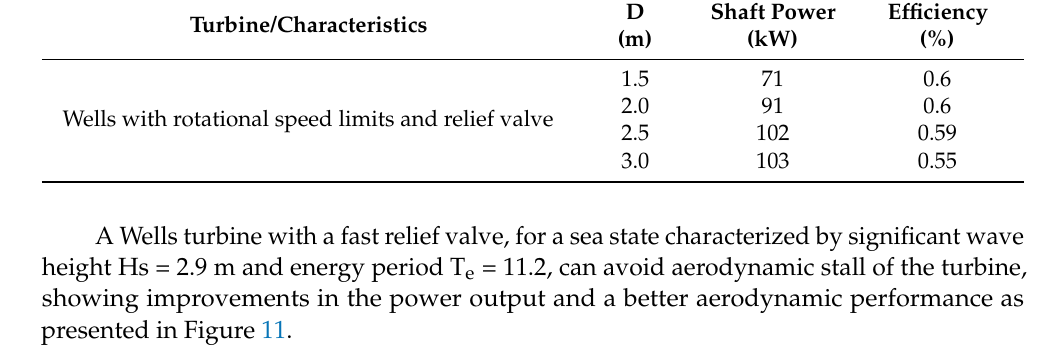
Figure 11. Instantaneous turbine shaft power and electric power for a Wells turbine for Hs = 2.9 m and D = 2 m.